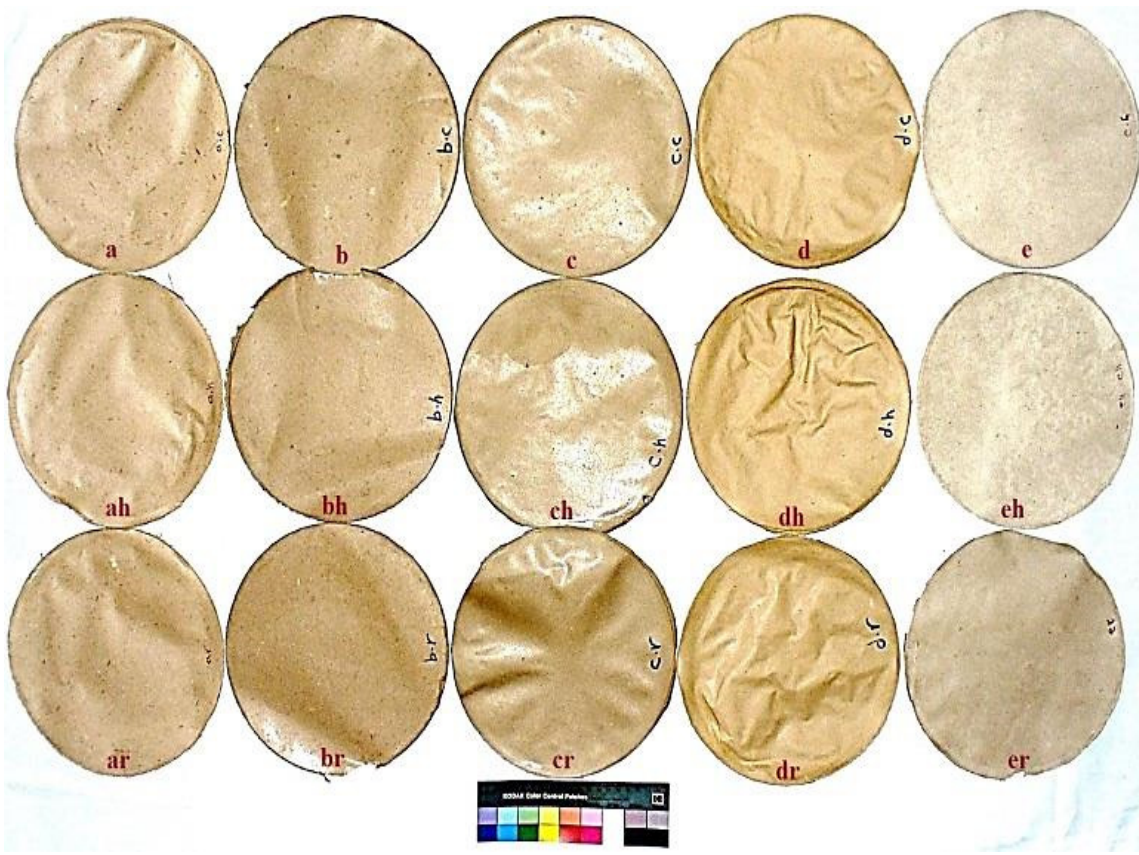
Figure 2. Paper sheets produced from wood species and after heating and iron rusting treatments; Schinus terebinthifolius ( a ), Erythrina humeana ( b ), Tectona grandis ( c ), Pinus rigida ( d ) and Juglans nigra ( e ). h, heated; r, iron-rusted.